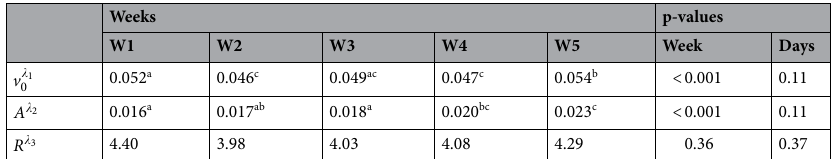
Table 2. Effect of the shift from the standard to a high-concentrate diet on synthetic variables describing the post-prandial kinetics of rumen hydrogen ion concentration [ H + ] along the 5 weeks of experimentation. Means without a common superscript letter differ significantly ( p < 0.05, a-d within a row). A the power transformed values of A and v 0 and R . W1 is associated with the time interval of distribution of the standard diet, and W2 to W5 with the distribution of the high-concentrate diet. Week and days describe the significance of fixed effects of the mixed model.